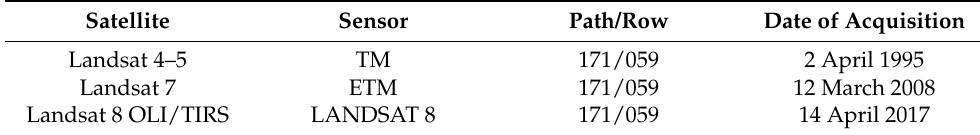
Table 1. Summary of Satellite Imagery used for Land cover change